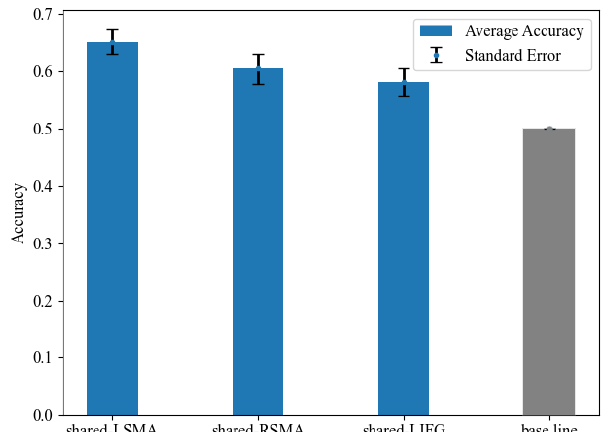
Figure 7. The classification accuracy and standard error in each shared region and the chance level of 50%. The accuracy in all ROIs was significantly above the chance level. Table 5. Results for MVPA between NA>NR and NV>NR. ROI Average Accuracy